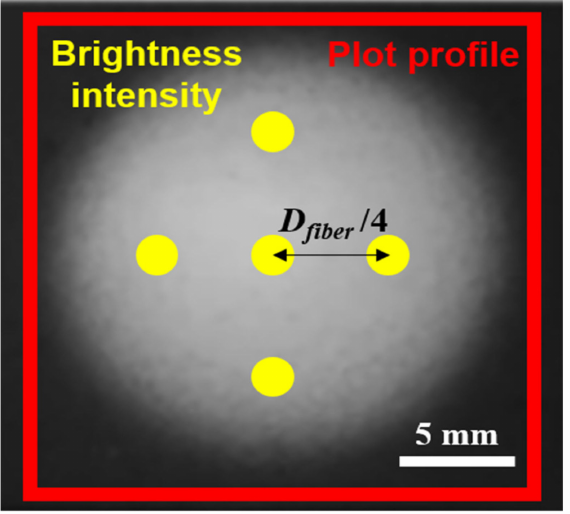
Figure 1. Brightness intensity analysis points and plot